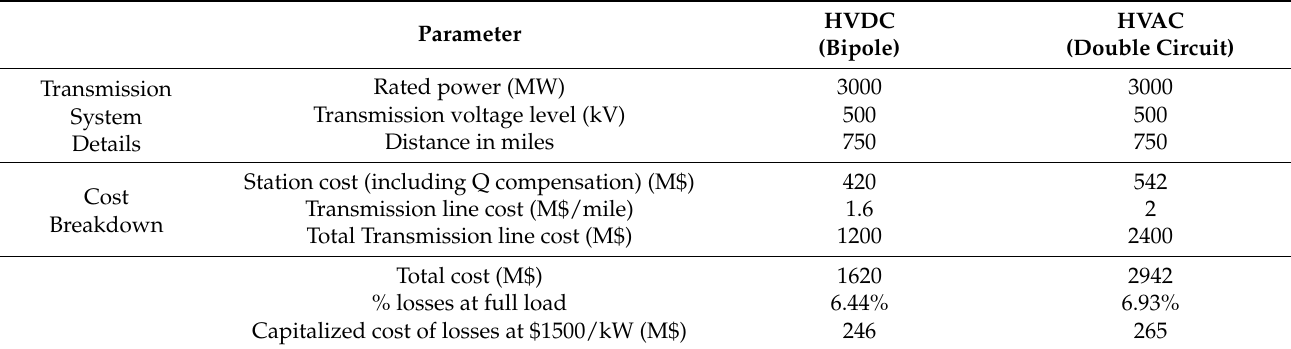
Table 3. Cost comparison of HVAC and HVDC transmission